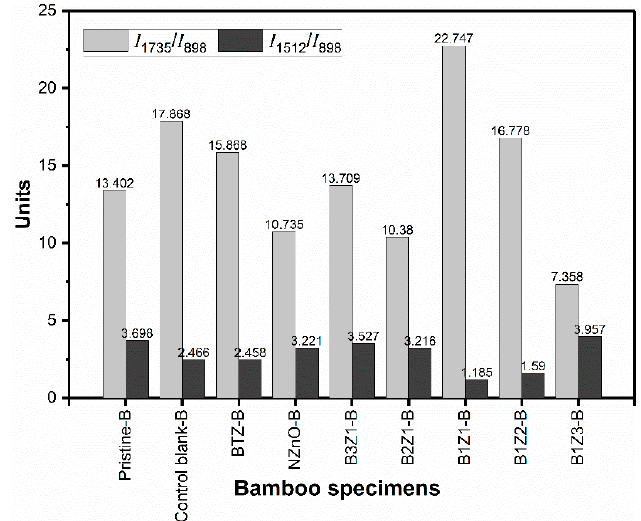
Figure 4. Changes in I 1512 / I 898 and I 1735 / I 898 values of bamboo beneath various films with di ff erent BTZ–NZnO ratios after 500 h of